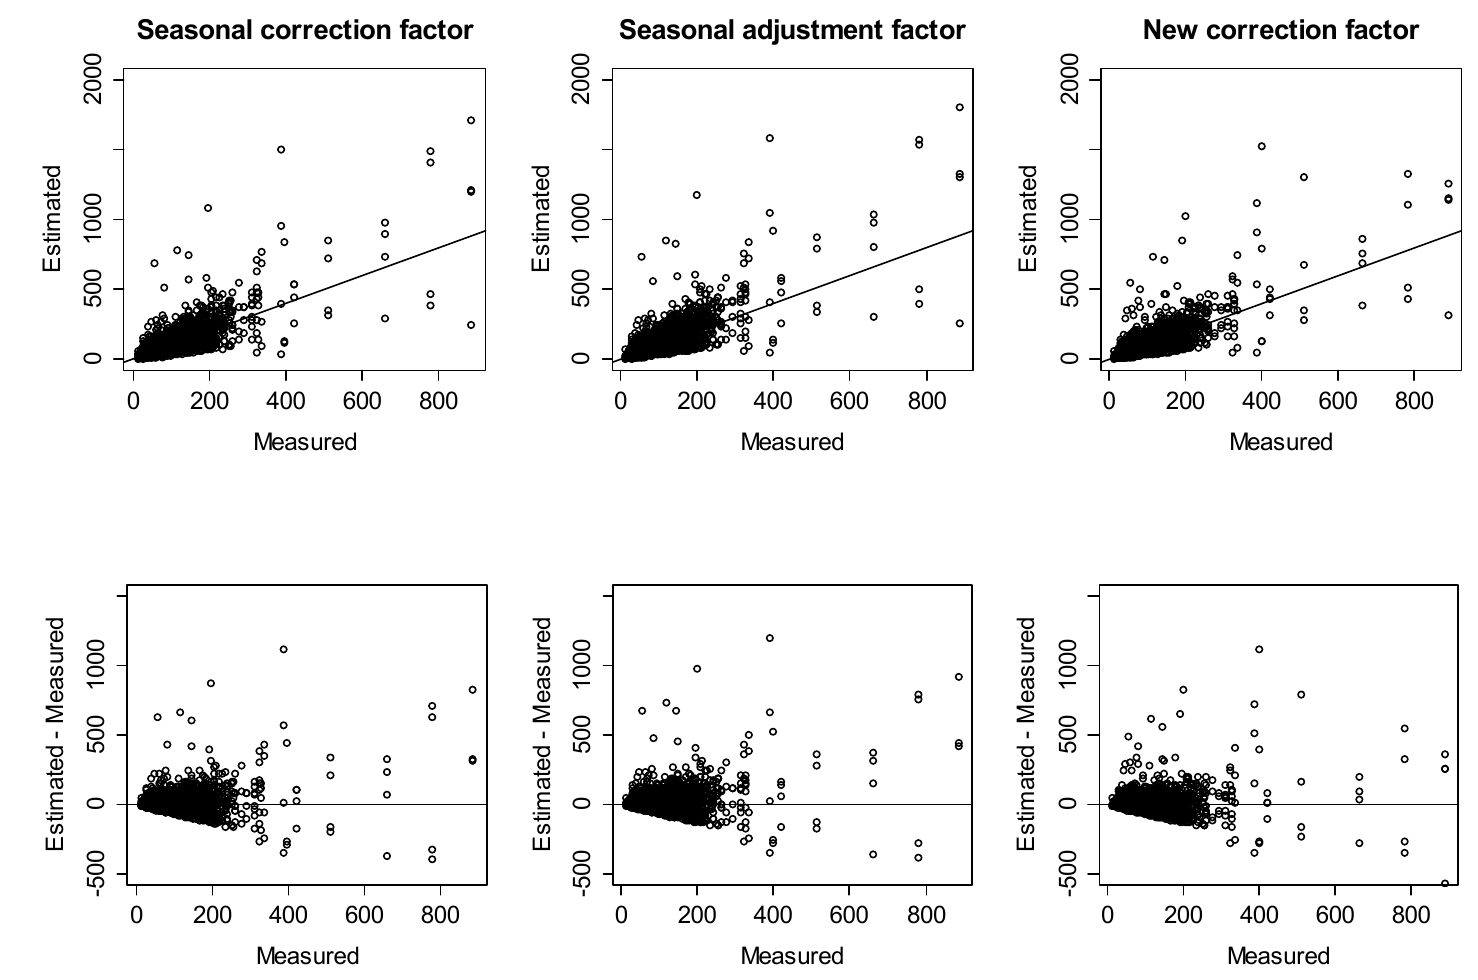
Figure 4. Comparisons of measured and estimated mean annual radon concentrations for detached houses.